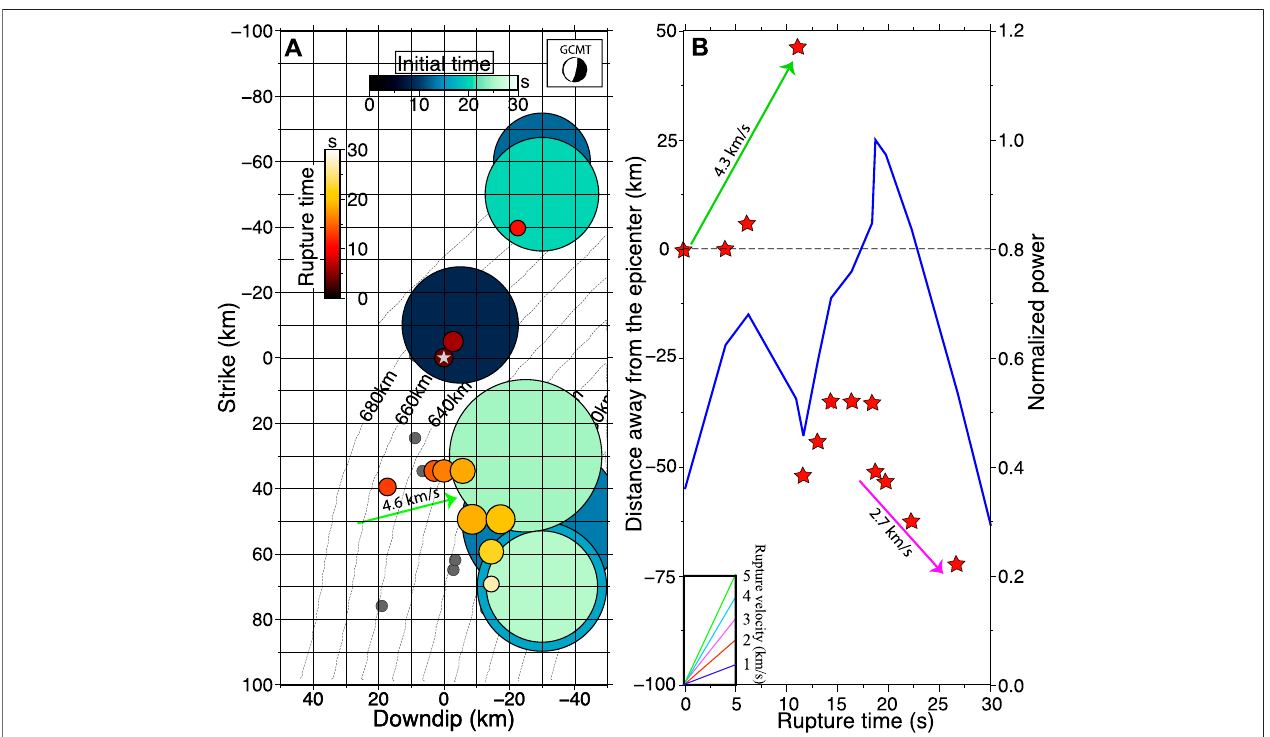
FIGURE 5 | Multi-array, multiband back-projection and multi-subevent rupture models. (A) Integration of the two source models. The ocean color bar in the fi nal inversion source model indicates initial times of the subevents, while the hot color bar in the back-projection model represents rupture times of the subevents. Circles indicate the subevents, whose areas are estimated in the Data and Methodology section and are proportional to the normalized power for the back-projection method. Whitestardepictstheepicenterandgraydotsdenoteaftershocks.Dashedcurvedlinesindicatethedepthcontoursofthesubductingslab(Hayesetal.,2012).The inset shows the GCMT focal mechanisms of the earthquake. (B) Distances away from the epicenter varying with rupture time (red stars) and normalized power of subeventsvaryingwithrupturetime (blueline).Momentreleasespeaks at6 sand18 s.Blue,red,purple,cyan,andgreenlines intheinsetrepresent rupturevelocitiesof 1 – 5 km/s.